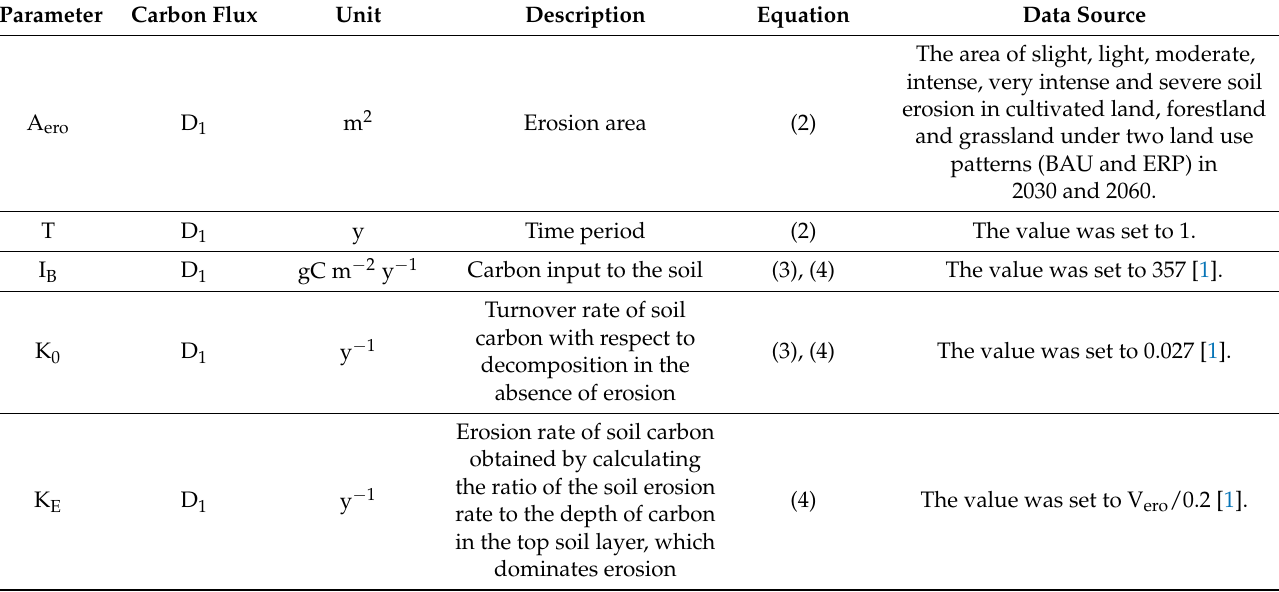
Table 1. Summary of parameters used in equations for calculating the carbon